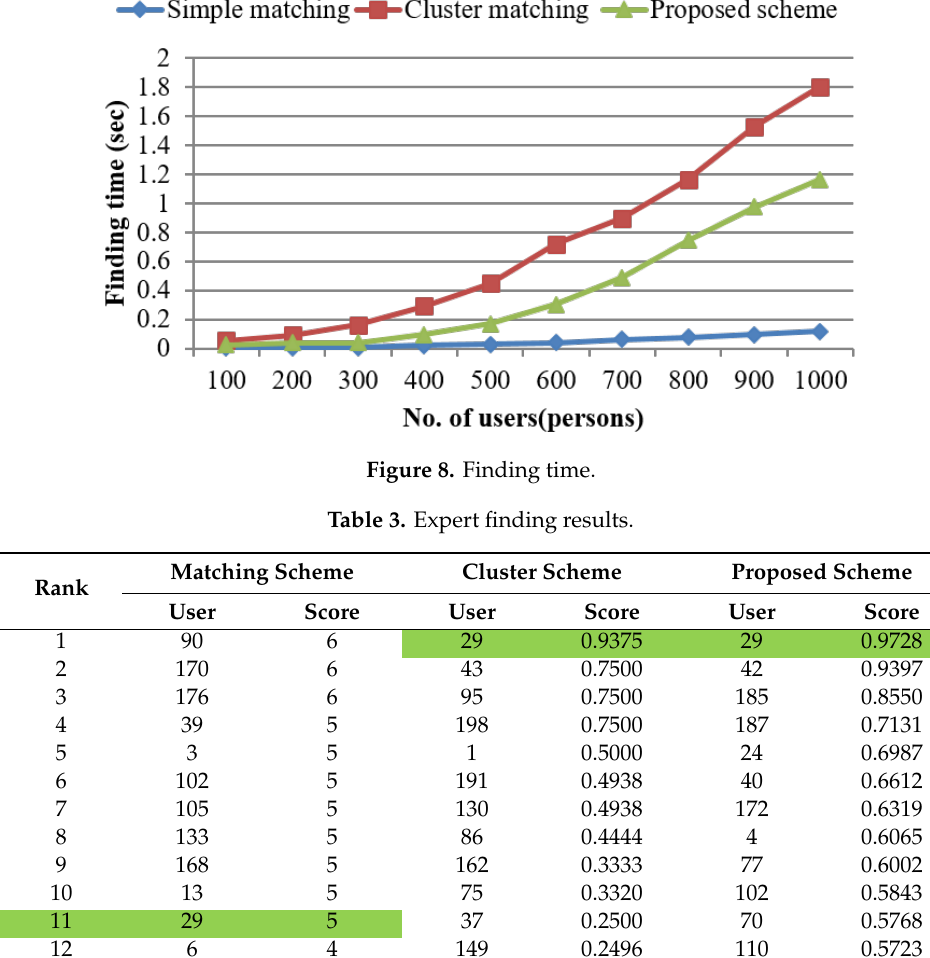
Figure 8. Finding time.